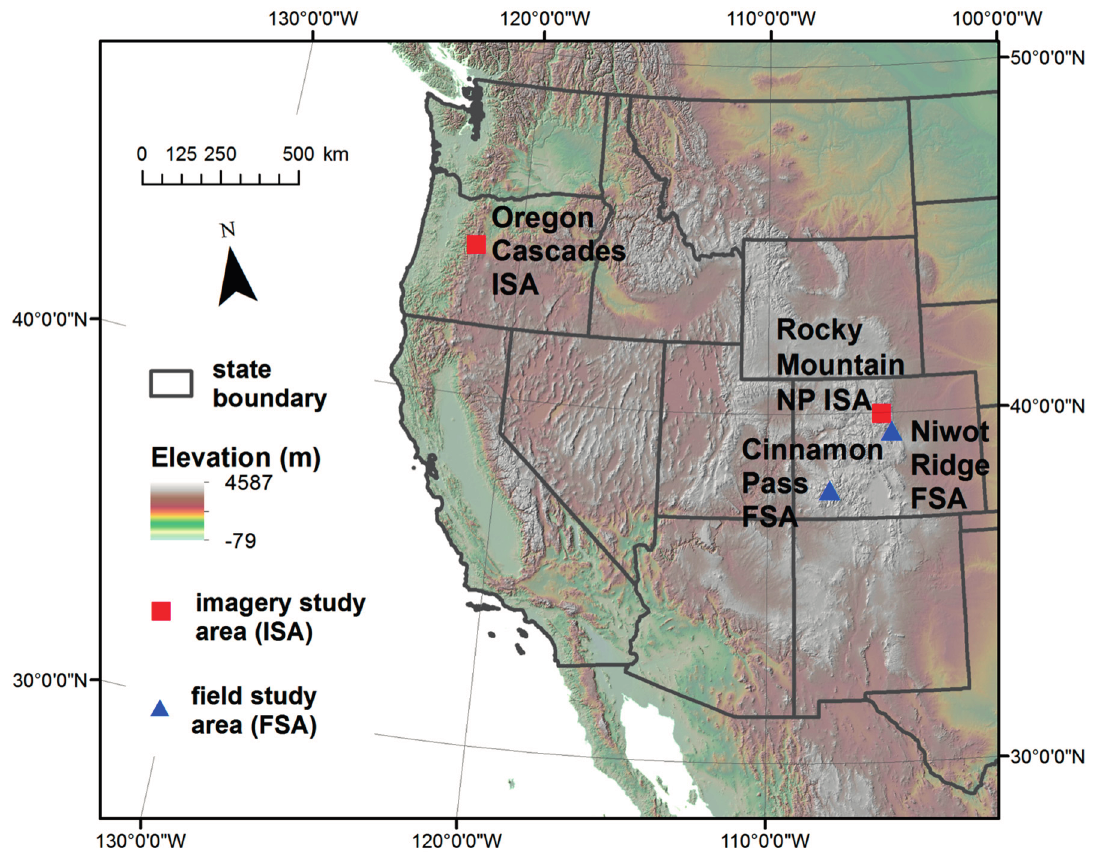
Figure 1 . Study area locations in the Western United States. The Oregon Cascades ISA is located in Oregon while the Rocky Mountain NP ISA, Niwot Ridge FSA, and Cinnamon Pass FSA are located in